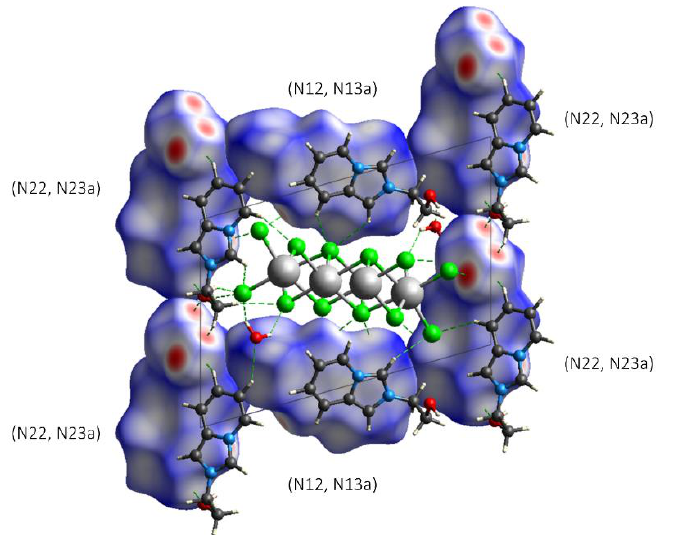
Figure 5. Hirshfeld surface mapped over d norm of (N12, N13a) and (N22, N23A) [L1] + cations for compound 1 (view along the a axis, the major component of the disordered (N22, N23A) cation is shown).